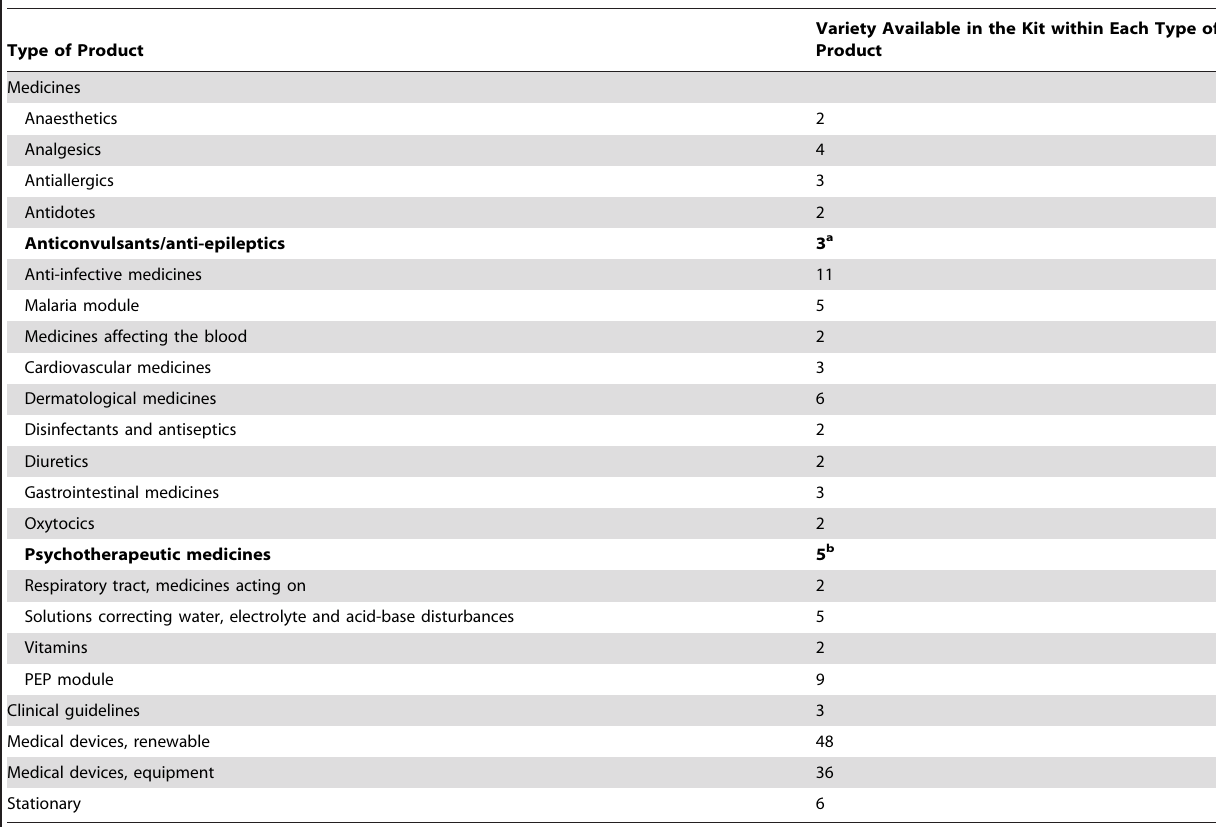
Table 1. Psychotropics in the next edition of the Interagency Emergency Health Kit [1].